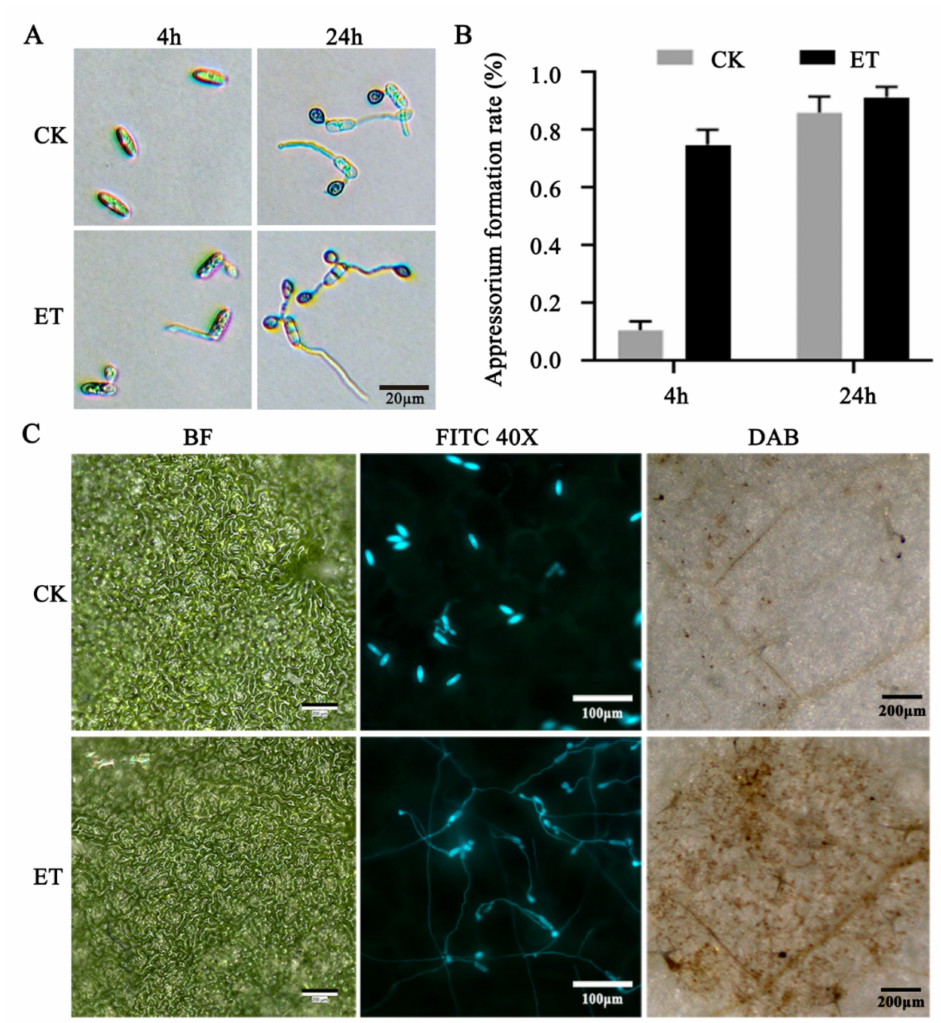
Figure 1. The phenotypic responses of C. gloeosporioides to ET during the in vitro culture and host infection processes. ( A ) Microscopic analysis of control (CK) and ET-treated samples. ( B ) The percentage of appressorium formation on glass in the CK/ET treatment groups based on calculating three replicates of 300 conidia for each sample. ( C ) Light and fluorescent microscopic visualization of Cg-gfp spores germinating and infecting Arabidopsis leaves; the DAB panel indicates the inoculation sites after DAB